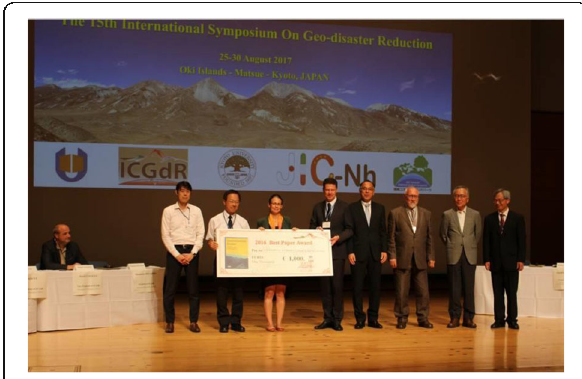
Fig. 5 The winner of the 2016 Best Paper Award of the journal Geoenvironmental Disasters